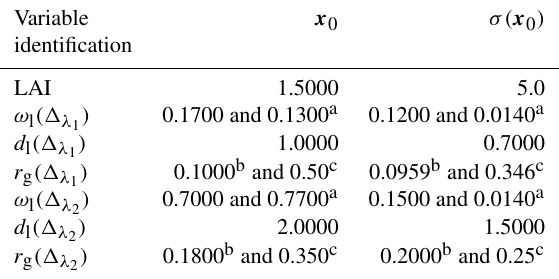
Figure 3. Prior 1.5 σ uncertainty for effective canopy single scatter- ing albedo (denoted by leaves) and background reflectance (denoted by snow in case of snow and by soils otherwise). Modified version of Fig. 1 from Pinty et al. (2008).